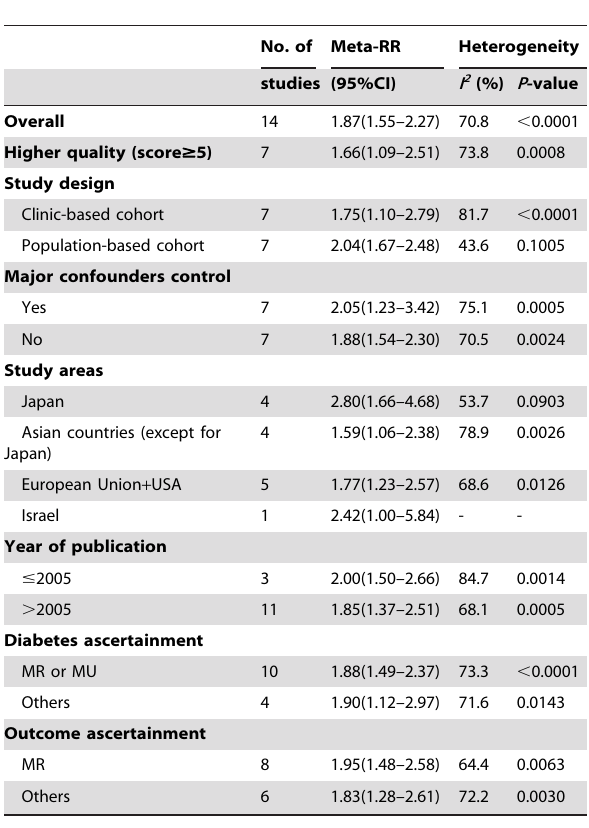
Table 2. Meta-analysis for pre-existing diabetes mellitus and HCC